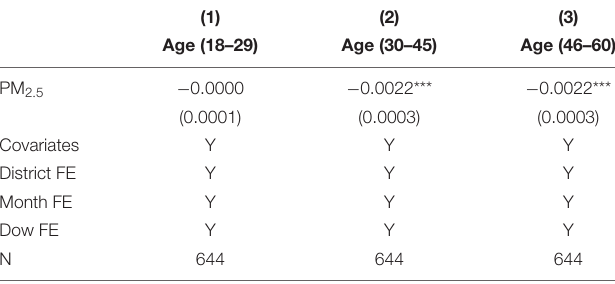
TABLE 7 | Heterogeneous relationship in different age.